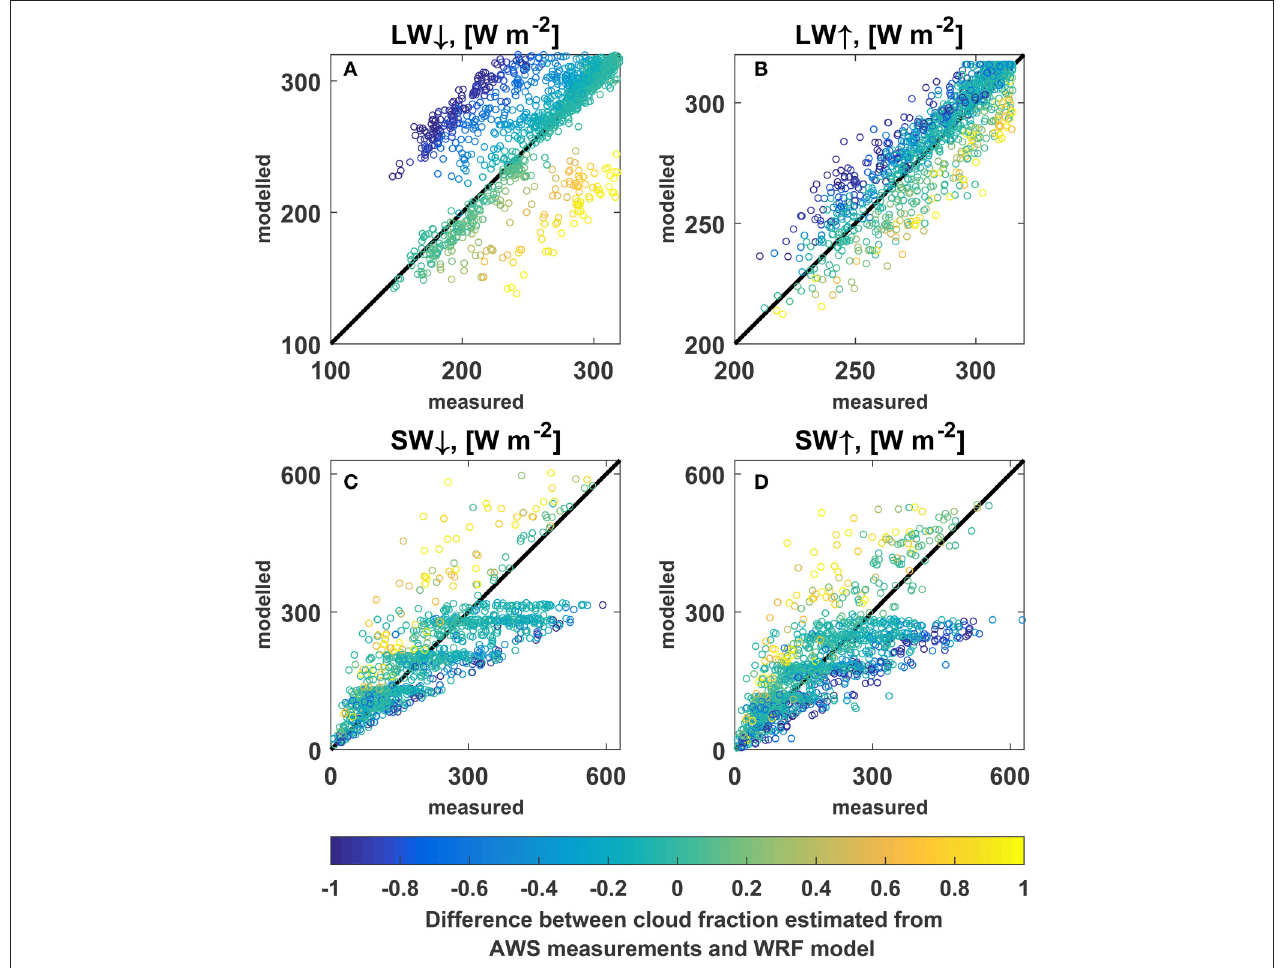
FIGURE 6 | Scatter plots illustrating the agreement between the measured and simulated intensities of the radiative energy fluxes at the Lomonosovfonna ice field during 23 April–14 July 2013 and 28 April–26 August 2014. (A) Long wave downwelling radiation. (B) Long wave upwelling radiation. (C) Short wave downwelling radiation. (D) Short wave upwelling